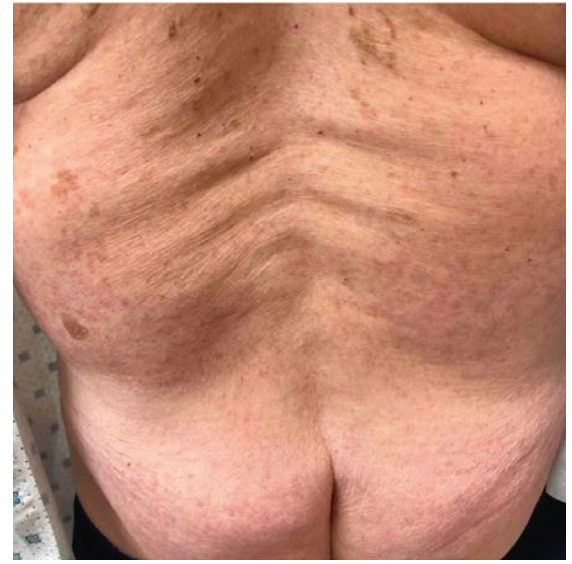
Figure 2: Image of the patient’s back demonstrating symmetrically distributed small, red, violaceous petechiae.